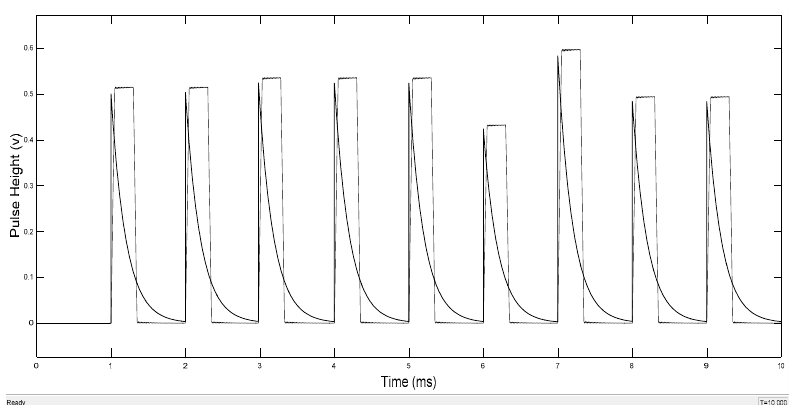
Figure 7. Non-pile-up using the TPS algorithm.